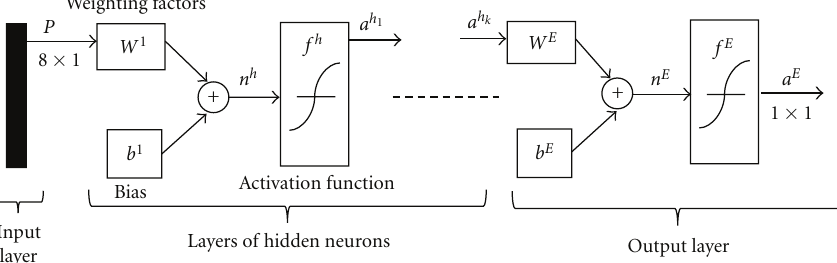
Figure 4: Typical structure of the applied neural networks.